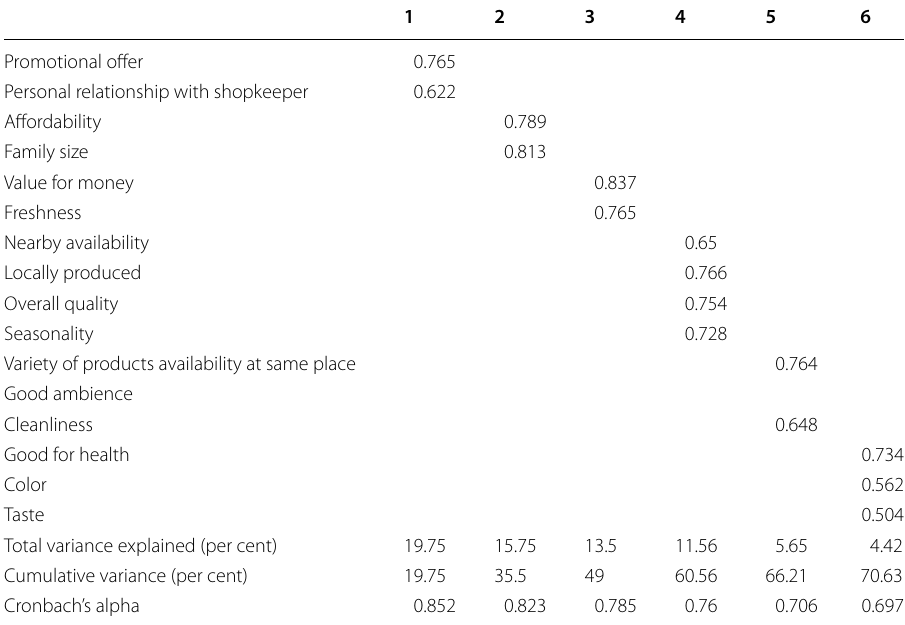
Table 14 Post-demonetization factor loading for various purchasing decision criteria for fruits and